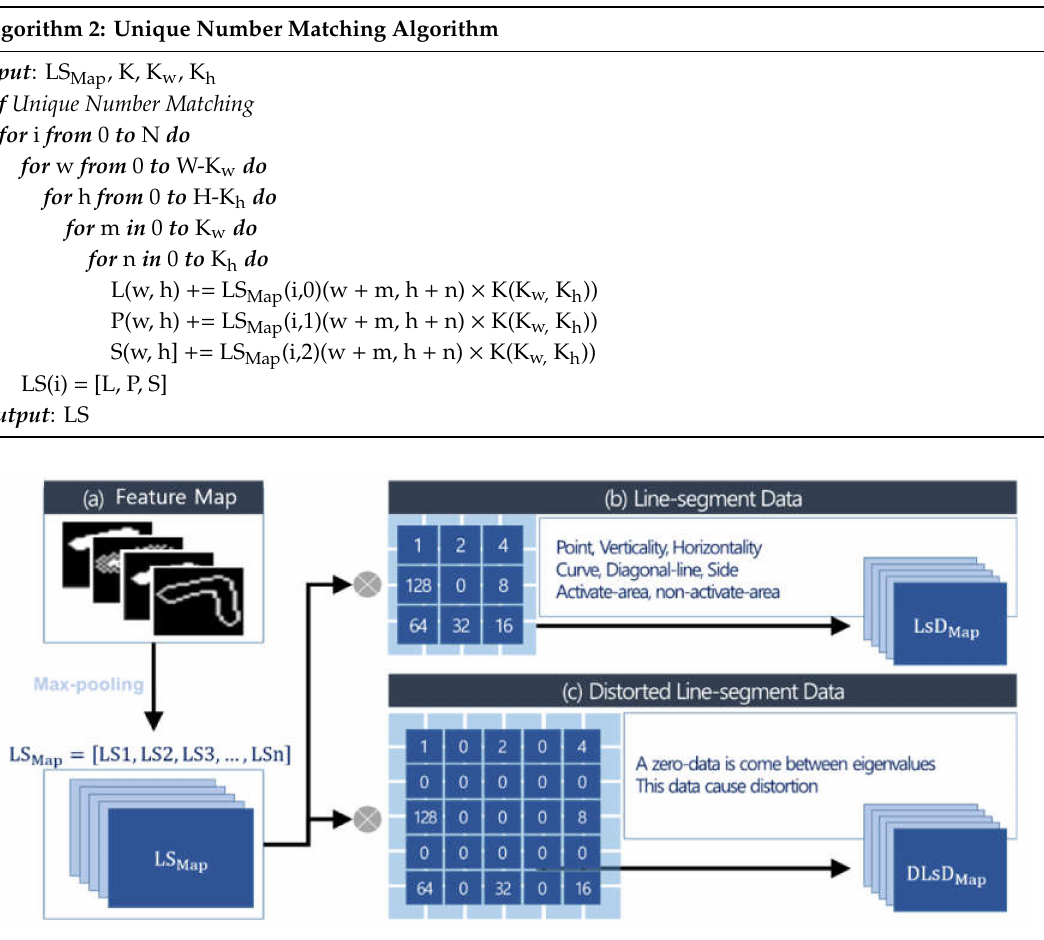
Figure 6. Unique number matching process of line-segment feature